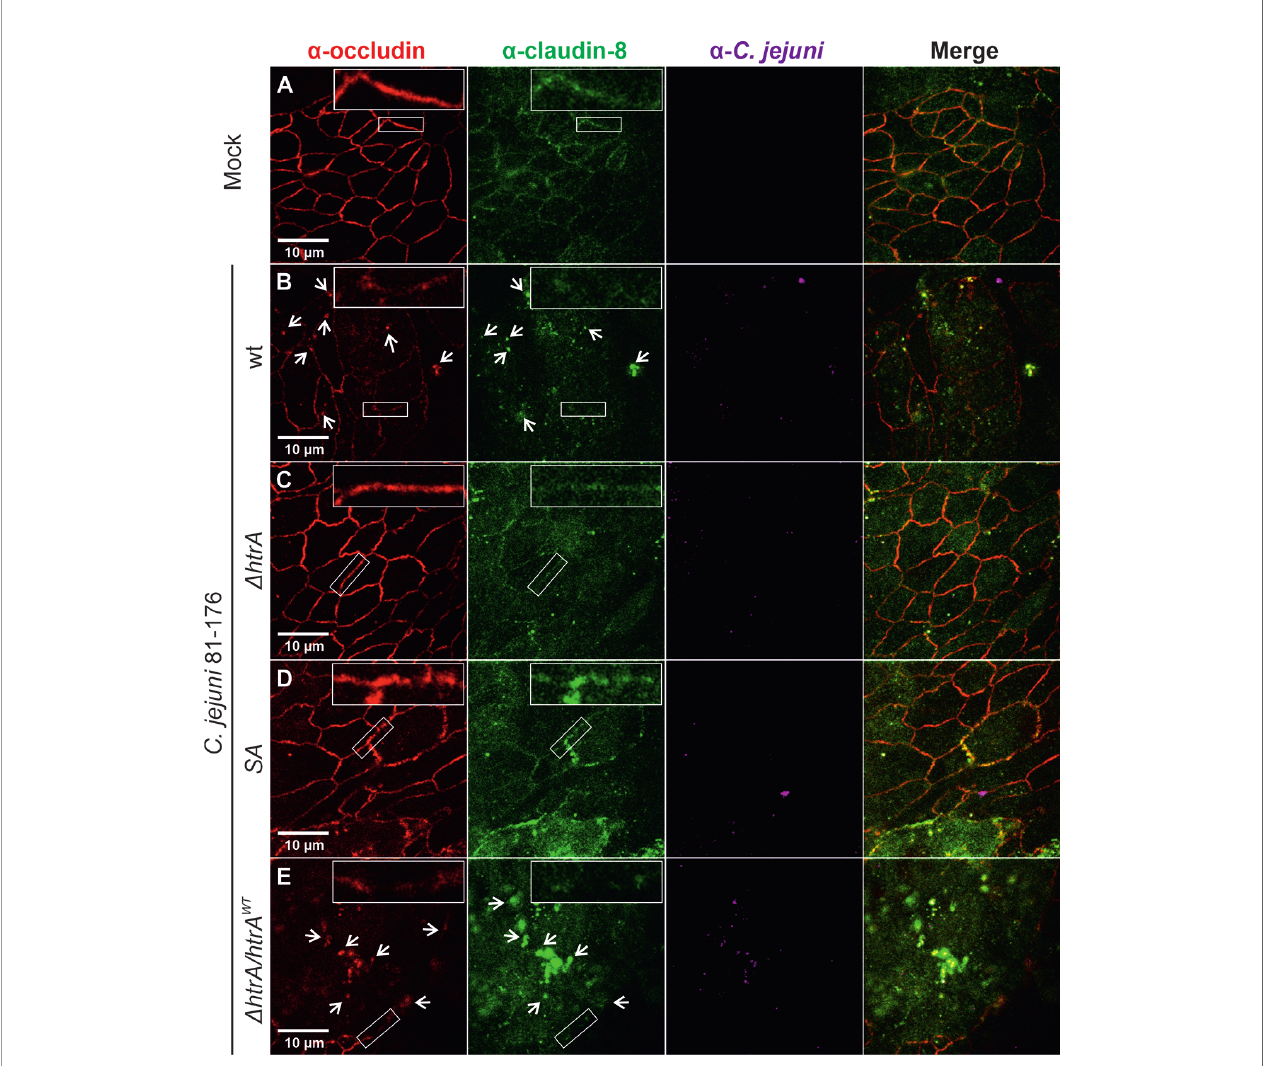
FIGURE 2 | Infection of polarized T84 epithelial cell monolayers by C. jejuni 81-176 leads to disruption of claudin-8 and occludin in the tight junctions. Epithelial cells were immunostained with a -occludin (red), a -claudin-8 (green) and a - C. jejuni (magenta) without infection (A) , or after infection with C. jejuni wild-type (wt) strain (B) , D htrA knockout mutant (C) , protease inactive SA mutant (D) or D htrA complemented with wt htrA (E) . White arrows indicate occludin and claudin-8 redistribution to protein agglomerates. White boxes contain enlarged parts of tight junctions from corresponding smaller white